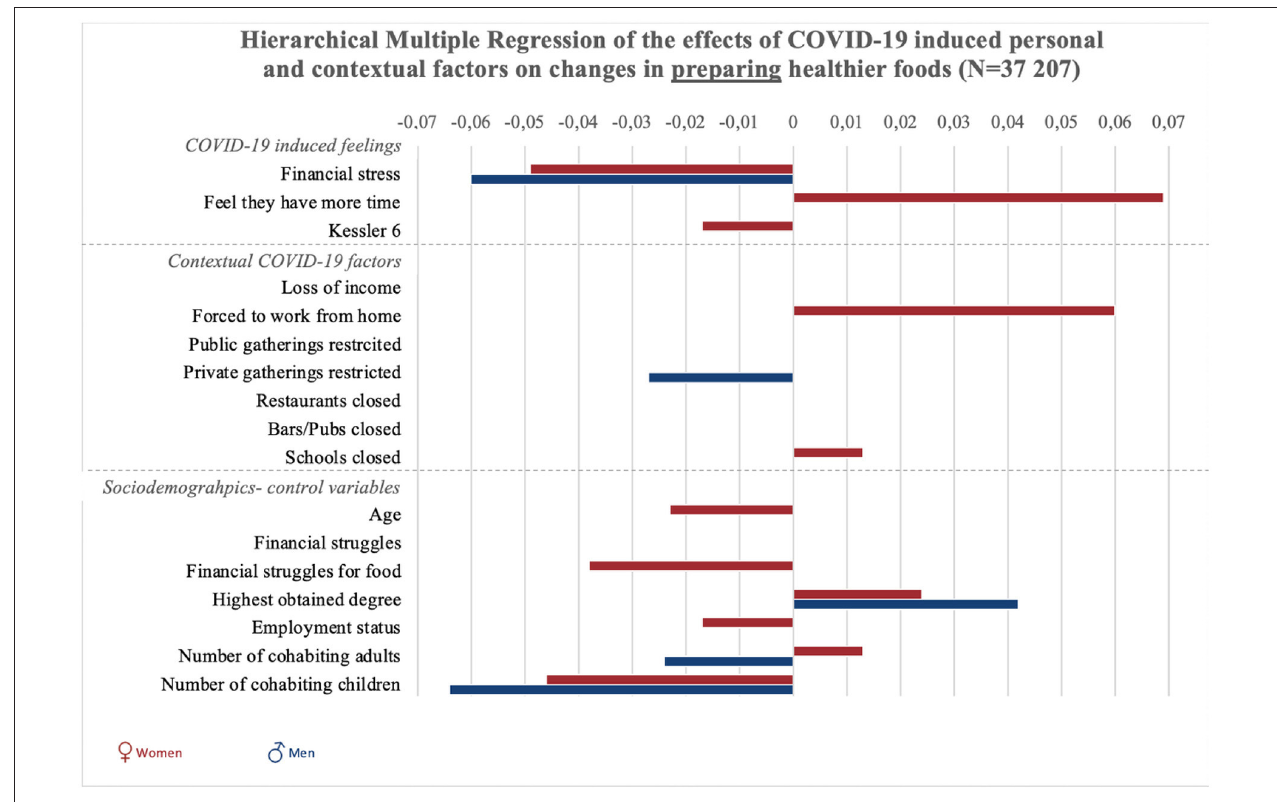
FIGURE 3 | Graphic summary of the significant relations between personal, contextual and sociodemographic variables and changes in preparing healthier foods during COVID-19. We report beta-values only for significant relations in models 2 for preparing healthier foods. Bars to the right indicate improvement in food preparation, bars to the left indicate decreases in preparing healthy